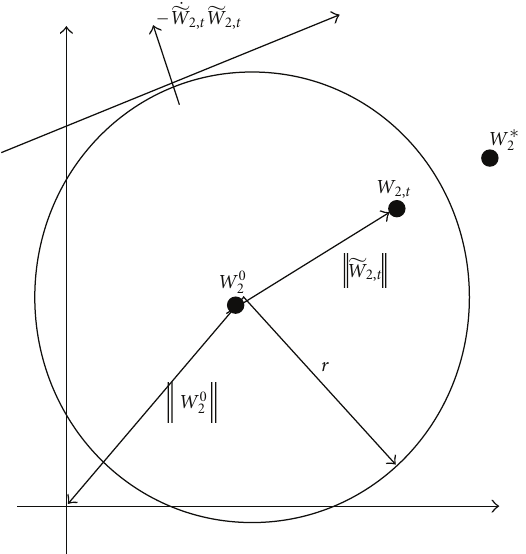
Figure 1: Projection